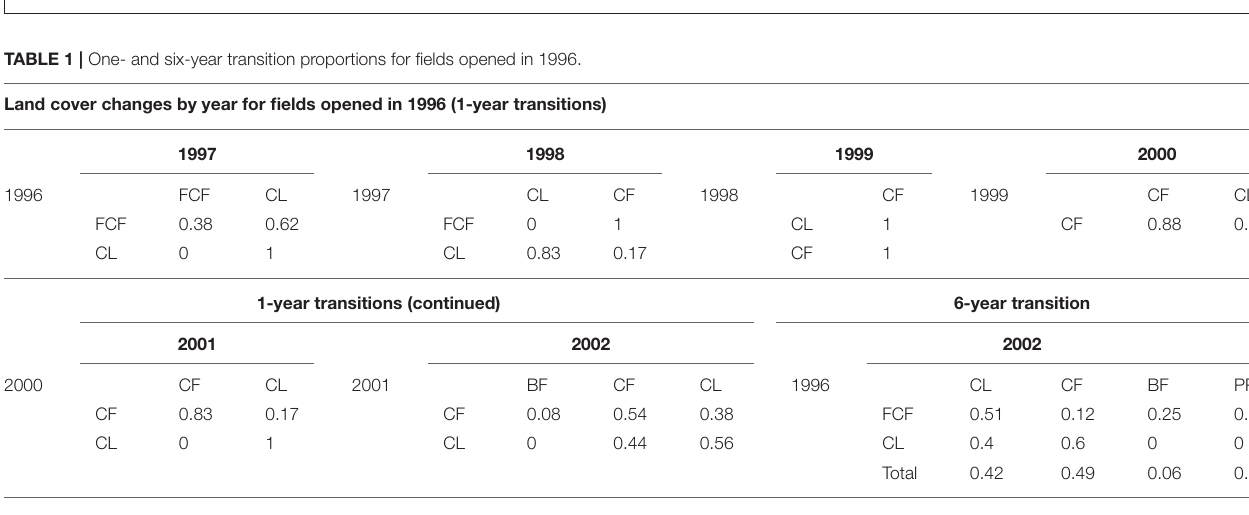
FIGURE 3 | Modeling pathways of temporal soil evolution under shifting cultivation (SC in red line) and under perennial plantations (PP in blue line).